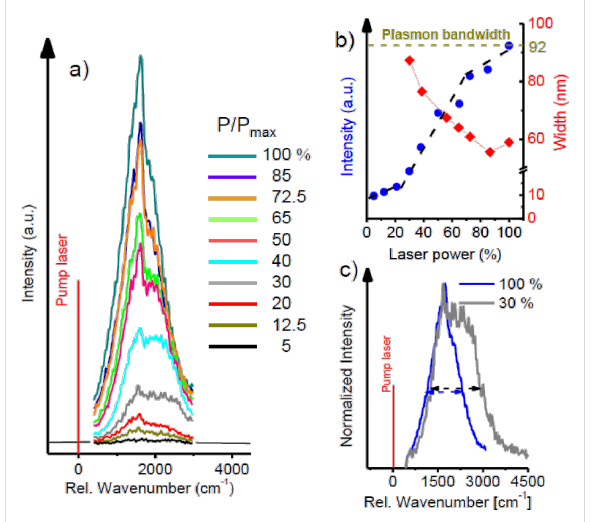
Figure 3: TERS spectra (a) recorded as a function of optical pump power (in % of the maximum pump power of 300 μ W) for a constant bias voltage of +1800 mV. Spectrally integrated intensity (blue dots) and the full width at half maxium (FWHM) (red diamonds) of the of the luminescence peak as a function of optical pump power are given in (b). The dashed lines are guides to the eye. (c) Spectral narrowing demonstrated by overlapping the spectra recorded at 30% and at 100% of the maximum laser